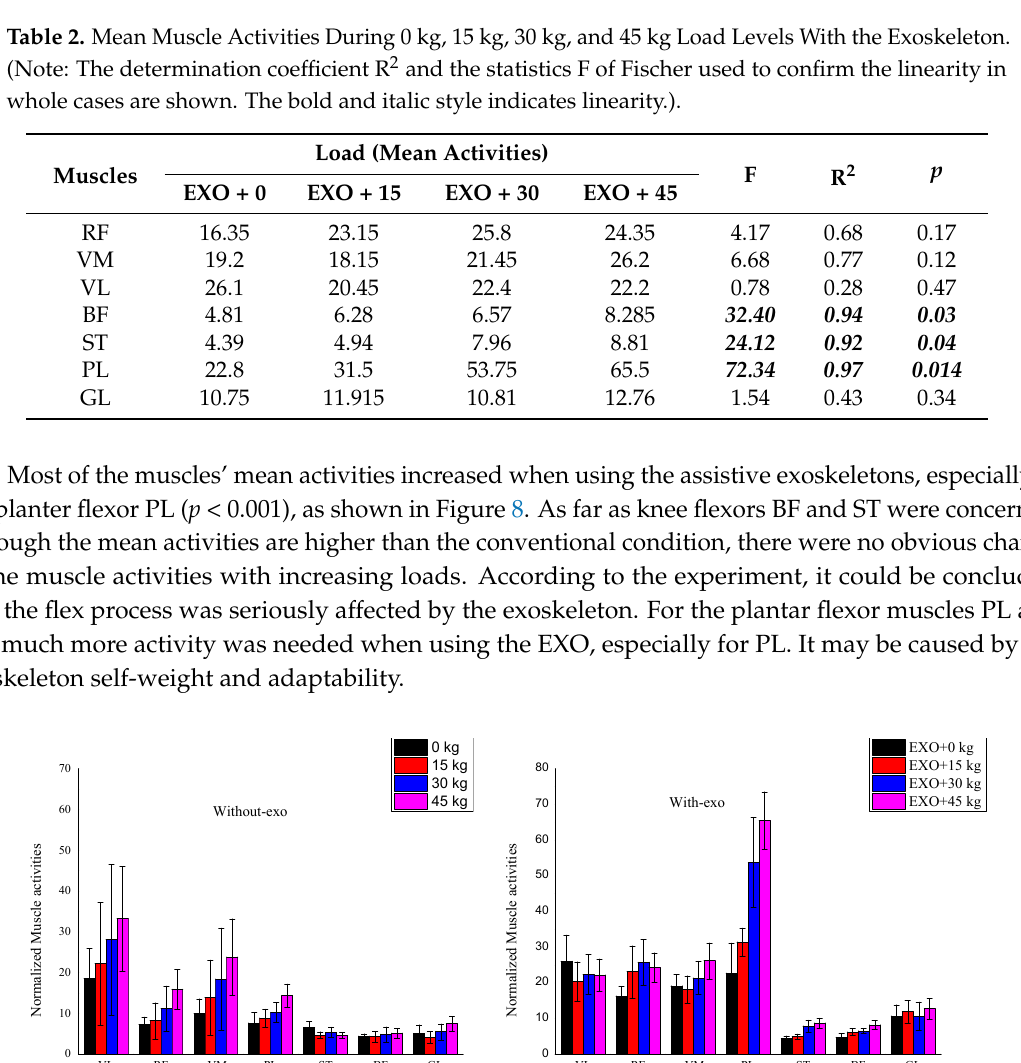
Table 3. Summary of Two-Way ANOVA Results for the Main and Interaction Effects of With or Without and Load Final EMG Values. W × L stands for with or without and load interaction. F means F test value. Lower-case p means statistical significance and the significant differences were bolded.